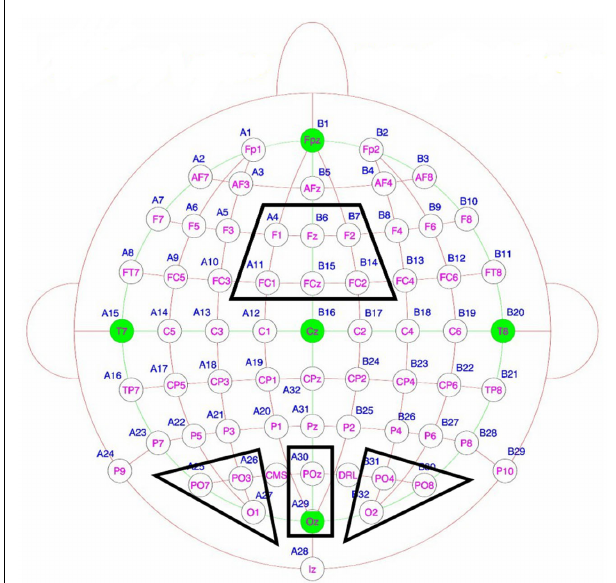
FIGURE 3 | Electrode sites of interest: the fronto-central, left occipital, central occipital and right occipital clusters. The two active electrodes are shown in yellow: CMS is the Common Mode Sense electrode which acts as a recording reference and DRL is the Driven Right Leg electrode which serves as a